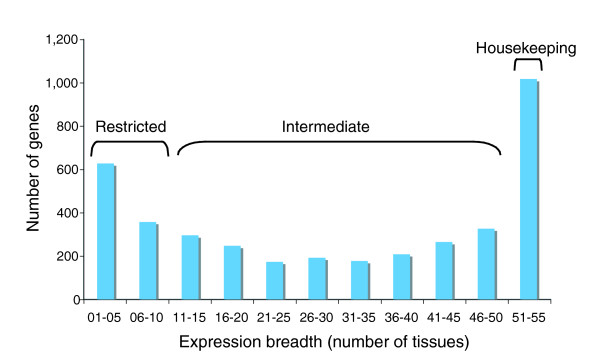
Mouse tissue expression distribution. We define three groups: low expression breadth (Restricted; 1-10 tissues), intermediate expression breadth (Intermediate; 11-50 tissues), high expression breadth (Housekeeping; 51-55 tissues).